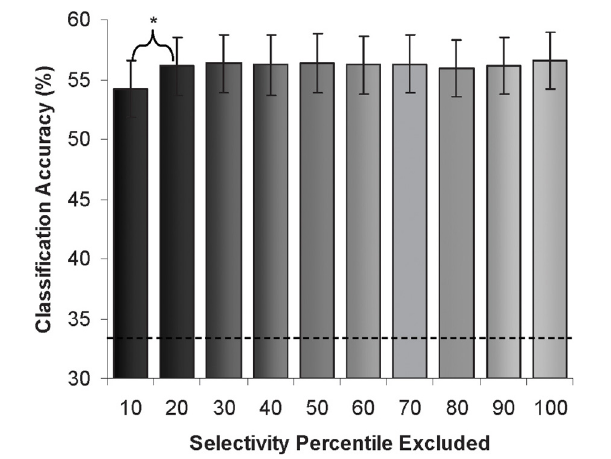
FIGURE 5 | Attention condition classification rates (% accuracy) after exclusion of each “object-selectivity” stratum. (Dotted line demarcates chance rate of